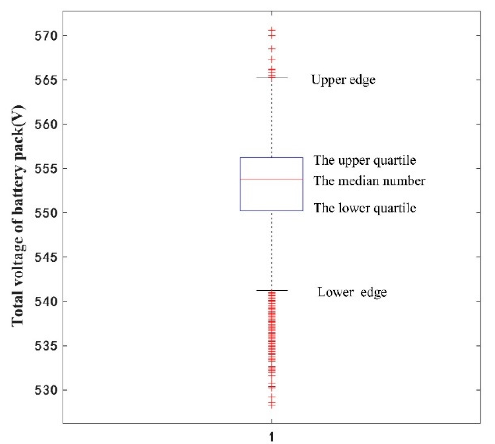
Figure 2. A box-type plot of the total voltage of a battery pack.